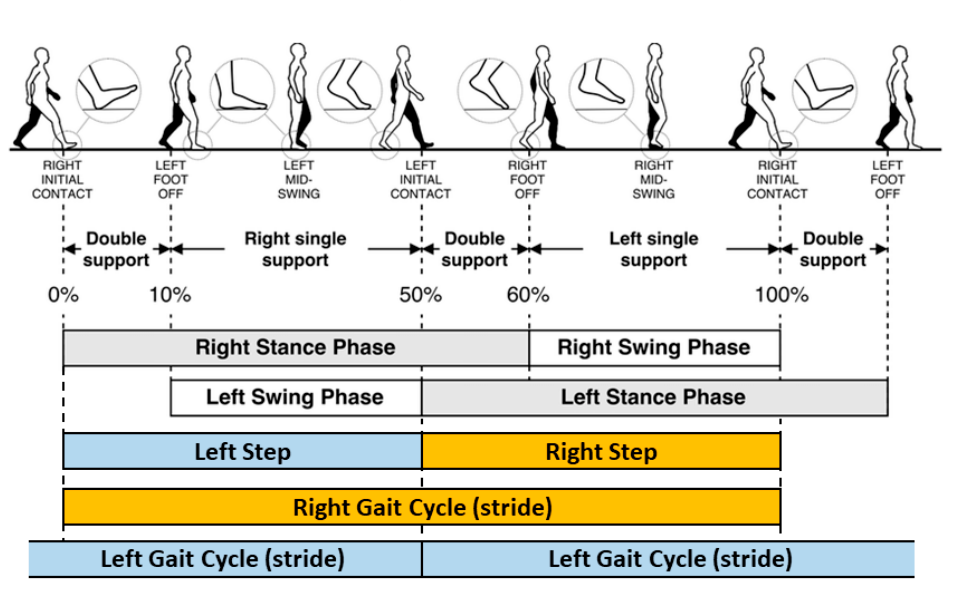
Figure 5. The heel-contact/initial contact (IC) and toe-off/final contact (FC) points identified from local minima and local maxima of the Gaussian continuous wavelet transform, of the processed vertical accelerometer signal.